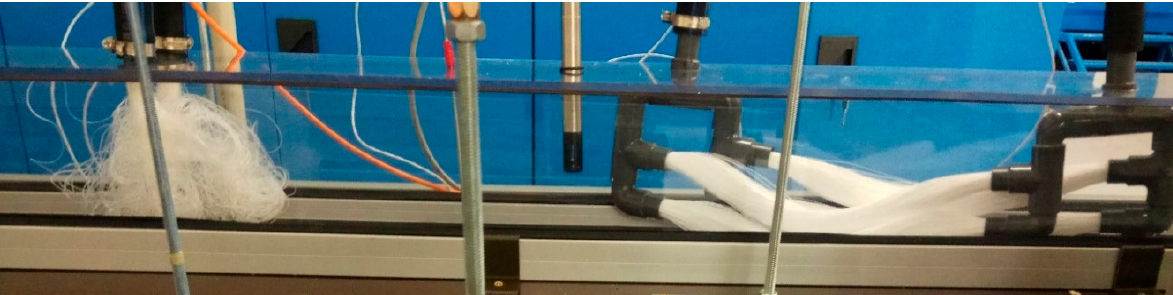
Figure 5. MM001 ( right ) with the condenser ( left ) inside the tunnel, the air flows from the right to the left. Based on the measured results of MM001, the other membrane modules are made of 140 mm fibers with an OD of 0.6 mm. These modules provide a much lower mass transfer area, but the fibers are stiffer. The length of 140 mm was chosen as it is the longest fiber option that can still be separated. The separation is done by pushing the module terminals towards each other by 20% of the original length. This method does not affect the hydro- phobicity of the fibers and causes no kinks. The separation of the fibers is shown in Figure 6. It can be also observed that when the module is made of two bundles, the sepa- ration of fibers is worse. This can in particular be seen in Figure 6, where the bottom bun- dle is limited by the separation of the fibers in the upper bundle. Although the separation of the bundles is similar (due to the dimensions of the fibers and their number), it is never identical. This can result in a slightly different mass transfer area. However, the difference is not significant as the membrane fibers are randomly touching each other. Figure 6. Testing section with MM007, condenser, MM004 and condenser (from right to left). 3. Results The results are presented separately for individual membrane modules. The lower index m, c, i, o marks the membrane module, condenser, input, and output, respectively. Each experiment is given a reference-EXxy, where xy is a number from 01 to 20 for better orientation. 3.1. Four-Bundle Membrane Module The test scheme for measuring MM001 is shown in Figure 4 on the left. MM001 was tested at two different membrane flowrates, (Qm) 100 and 60 L/h, and for three different